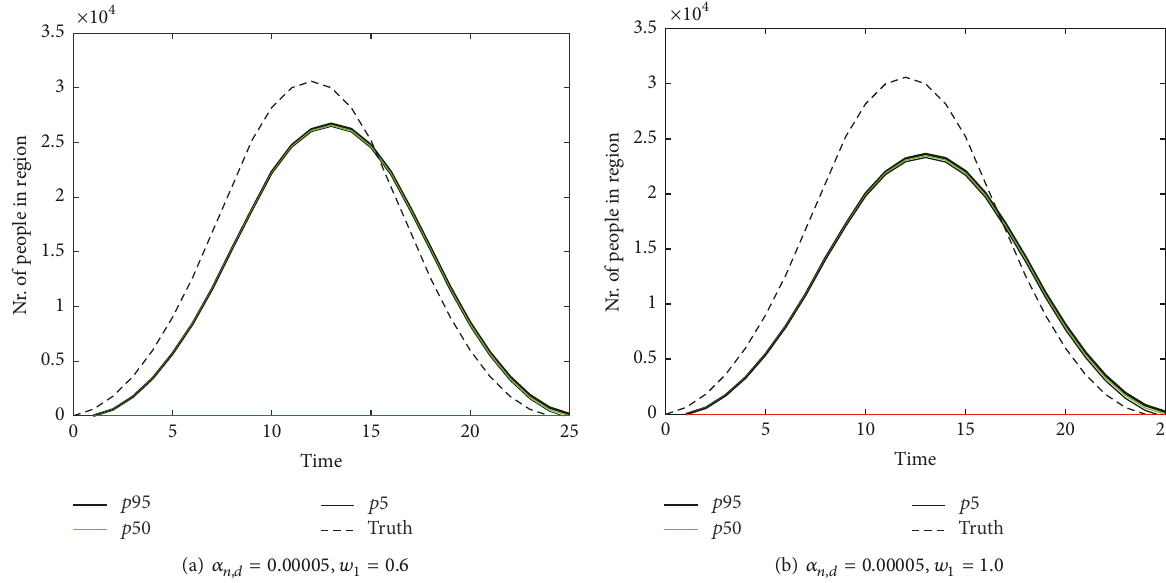
Figure 7: Case 2: visualisation of the solution space provided by the Monte Carlo simulation for given combinations of 𝛼 𝑛,𝑑 and 𝑤 1 , where the dashed line of the total demand represents the ground truth, and 𝑝5 , 𝑝50 , and 𝑝95 represent the 𝑥 th percentile of the distribution of realizations of the amount of pedestrians in the area at time 𝑡